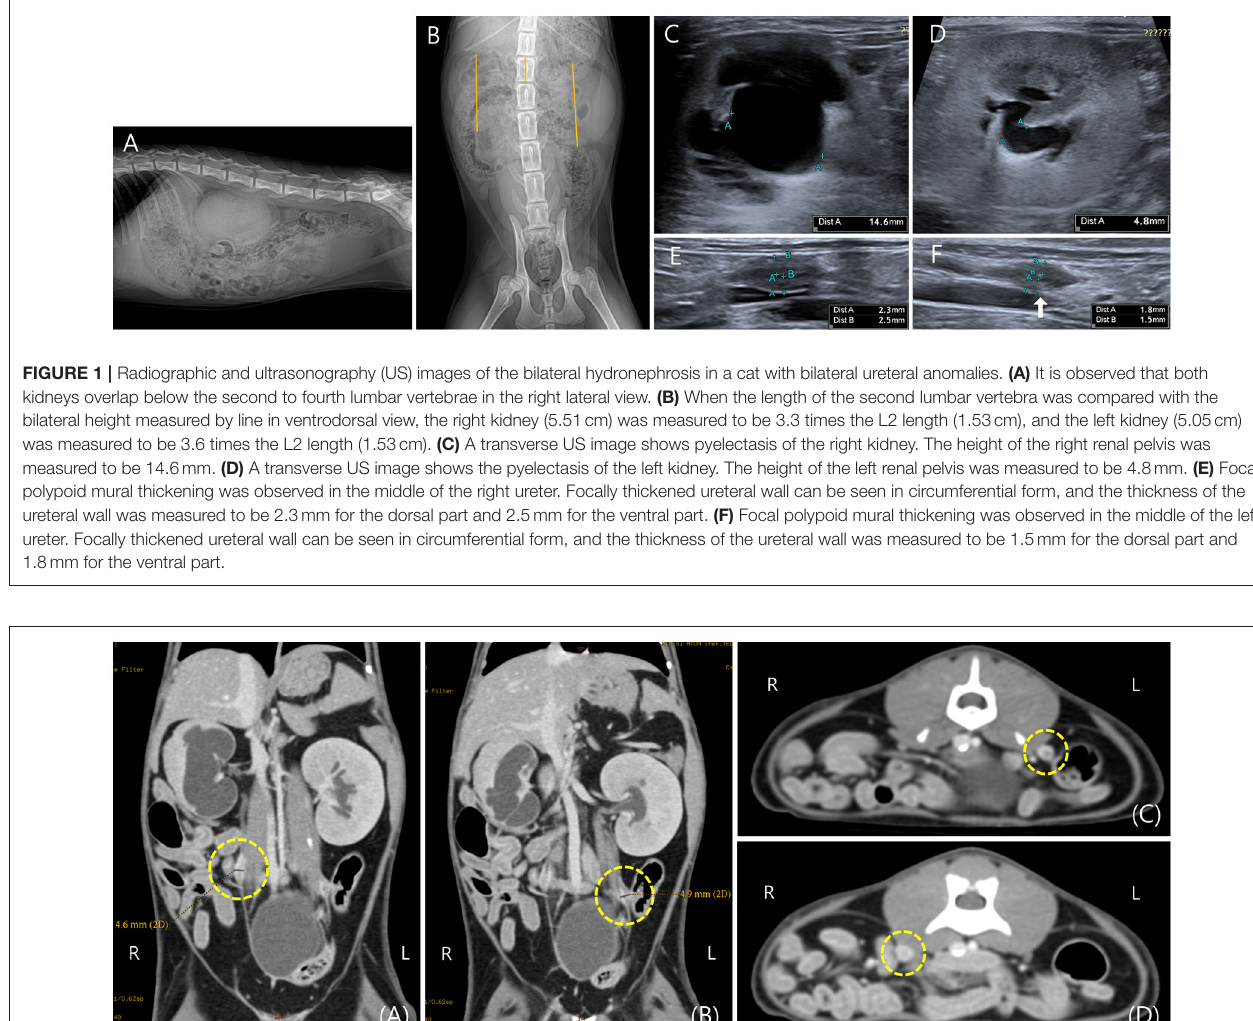
observed in the middle parts of the bilateral ureters. When the areas were cut in half, they found that the surfaces of the lumens were irregularly protruded ( Figures 3A,B